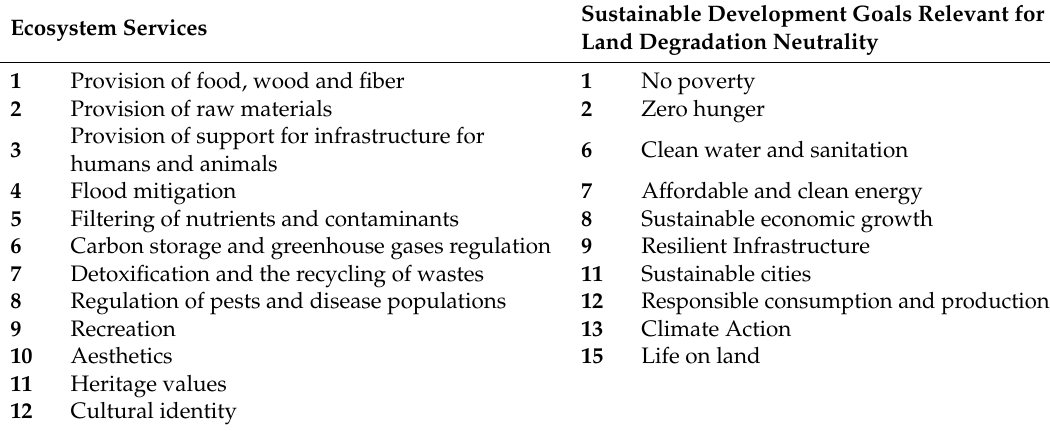
Table 2. Overview of ecosystem services and Sustainable Development Goals (SDGs) relevant for Land Degradation